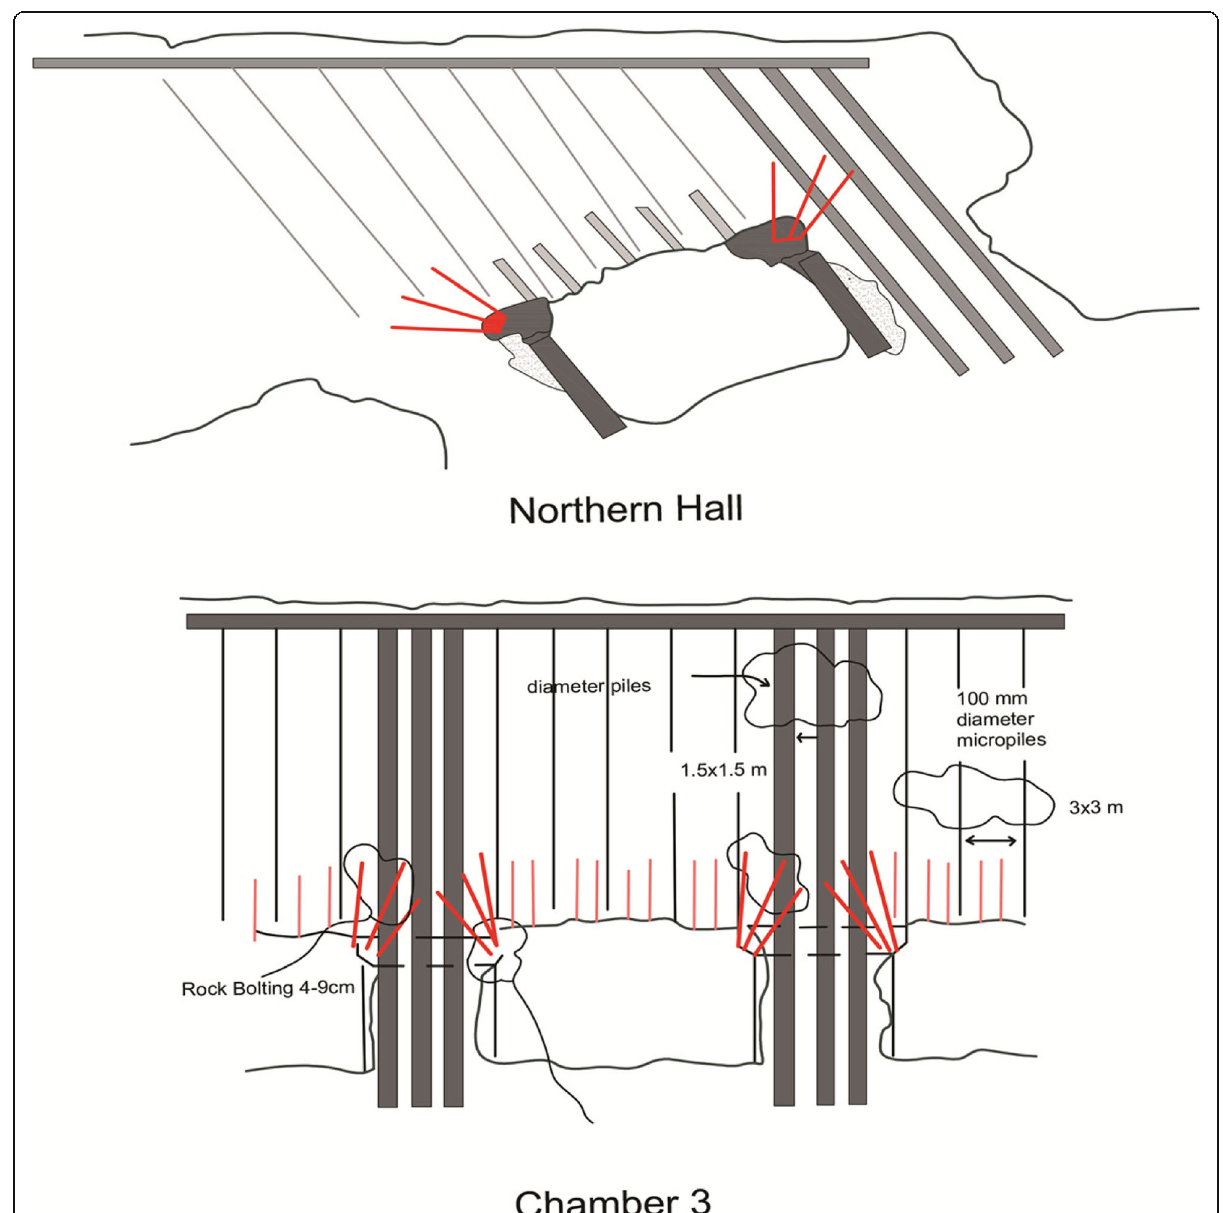
Fig. 34 Design of rockbolts, prestressed anchors and micropiles for the permanent support system for the rock pillars and sidewalls of the